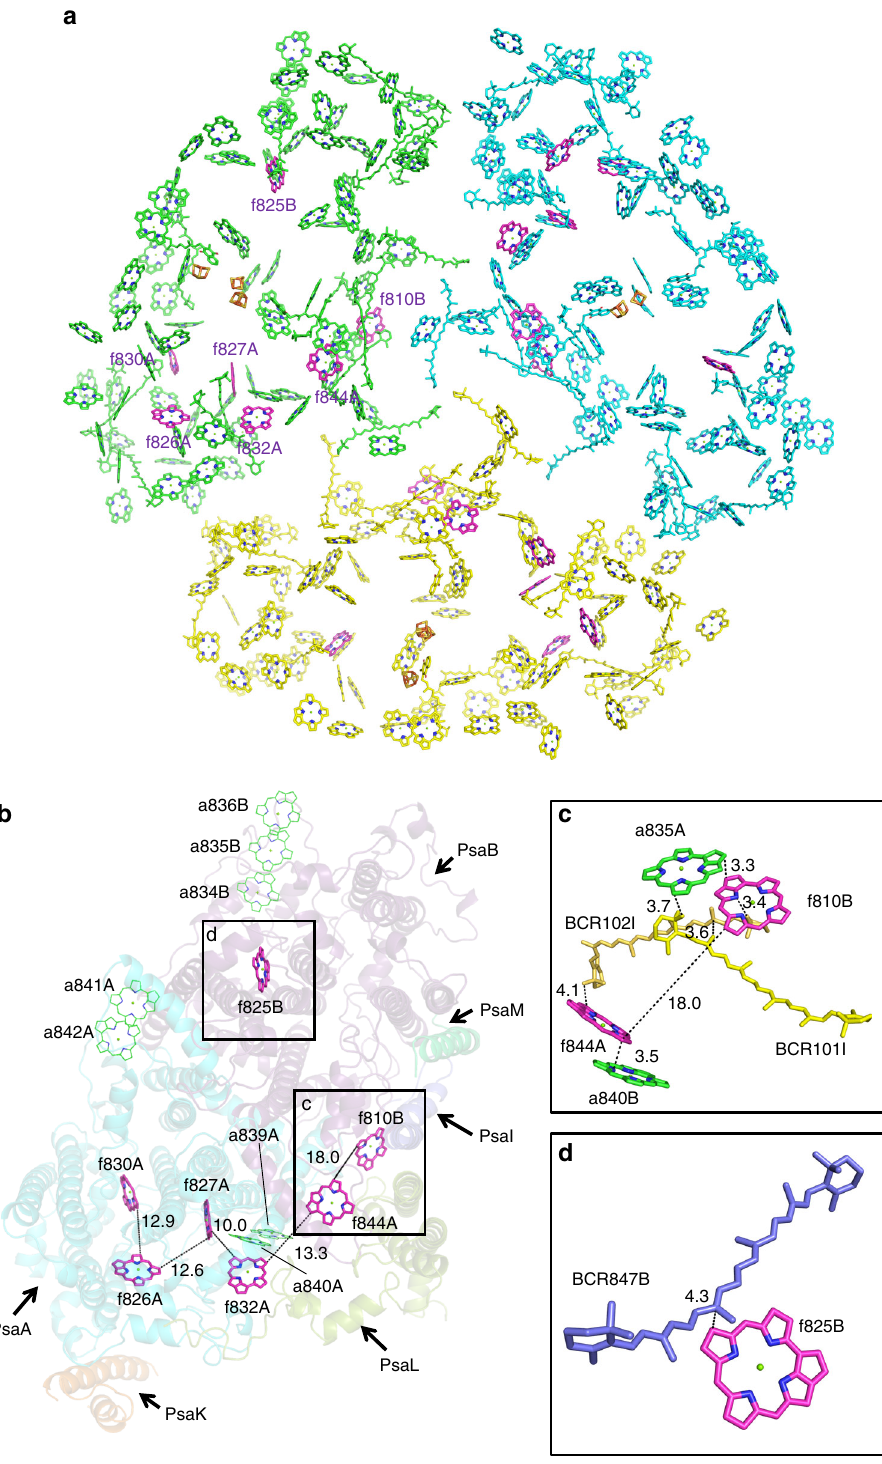
Fig. 4 Arrangement of pigments in the far-red PSI trimer. a Arrangement of the pigments in a far-red PSI trimer viewed along the membrane normal from the stromal side. The Chls f are colored in magenta, and other cofactors are colored in cyan, yellow and green in three monomers, respectively. b Arrangement of Chl f in a far-red PSI monomer viewed along the membrane normal from the stromal side, with the protein subunits depicted in a cartoon model. For clarity, PsaC, PsaD, and PsaE are not shown in the model. Chls f and several Chls a that are assumed to form red Chls are colored in magenta and green, respectively. c , d Close-up views of nearby pigments of f844A and f810B c , f825B d